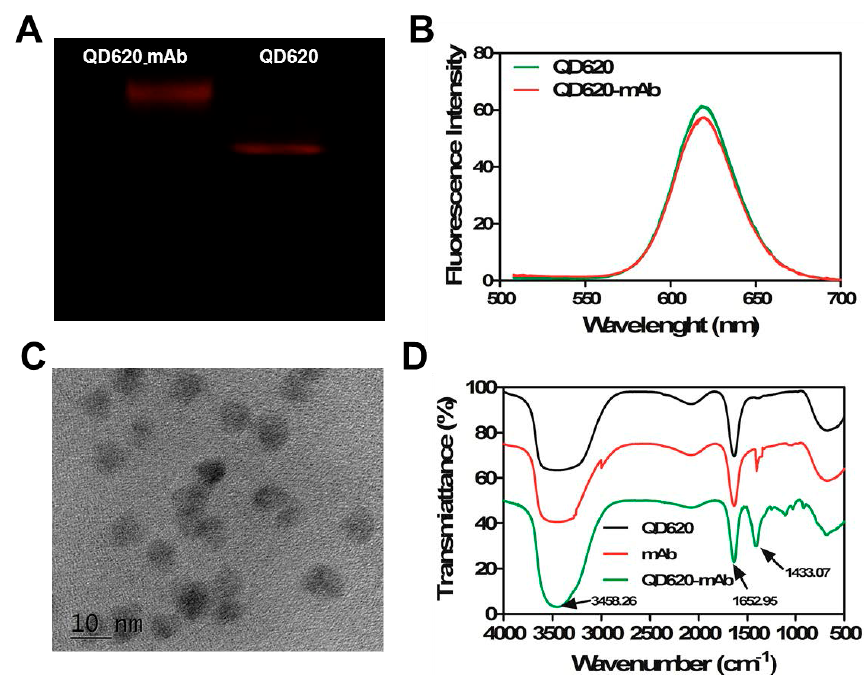
Figure 1. The conjugation of QD 620 and monoclonal antibody anti-RUS. ( A ) the gel electrophoretic mobility of QD 620 before and after conjugation; ( B ) the fluorescence spectra of QD 620 before and after conjugation (The excitation wavelength was set at 400 nm); ( C ) the TEM images of QD 620 -mAbs; ( D ) the FT-IR spectra of QD 620 , mAbs, and QD 620 -mAbs.